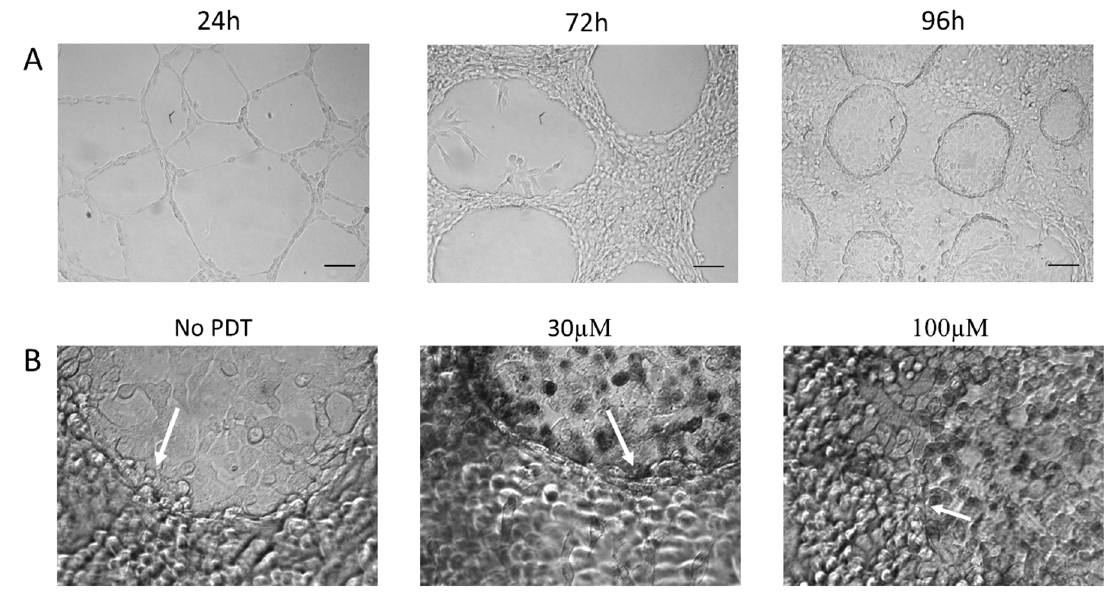
Figure 4. PDT on three-dimensional cultures with Pd(T4) with 405 nm irradiance. ( A ) C918 were grown on Matrigel to acquire three-dimensional cultures over 24 h, 72 h, and 96 h. Scale bar is 100 µm ( B ) Cells were grown for 120 h and left untreated or exposed to Pd(T4) at 30 µ M and 100 µ M with subsequent 15 J/cm 2 of 405 nm. Arrows point to vasculogenic mimicry-forming cells. Magnification 200×. Table 1. Three-dimesional oncolytic effect of PDT with Pd(T4) and 405 nm irradiance on C918 cells. % death in 3D culture Treatment Dosage (J/cm 2 )